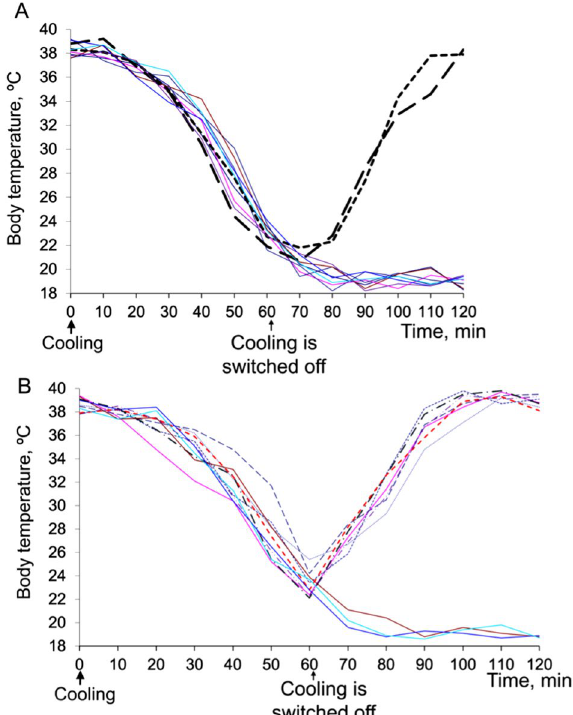
Figure 7. SkQ1, administered 1 min after the end of cold exposure, increased survival and accelerated the return to normal body temperature. Mice were exposed to − 20 °C for 1 h and then returned to room temperature. ( A ) Without SkQ1. ( B ) SkQ1 (1.5 μmol/kg) was introduced intraperitoneally 1 min after cessation of cooling. The solid curves show the body temperature of mice that died after the cold shock (8 out of 10 in ( A ) and 3 out of 10 in ( B )); dashed curves, mice survived after cooling.